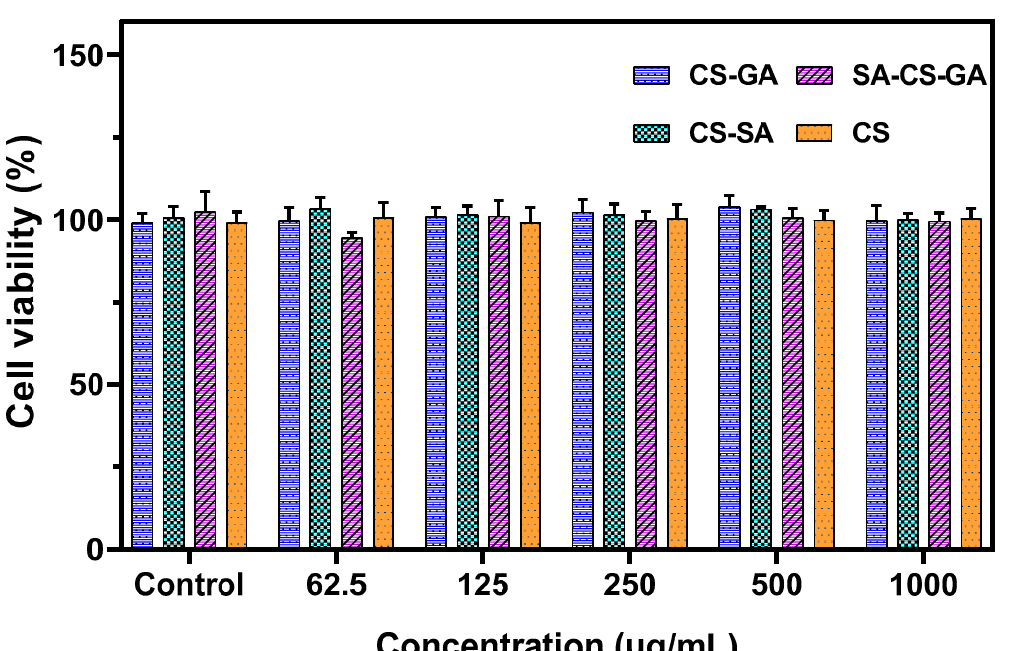
Figure 4. Viability of HaCaT cells after 24-h exposure to novel chitosan derivatives at different concentrations. Data are presented as mean ± SD.